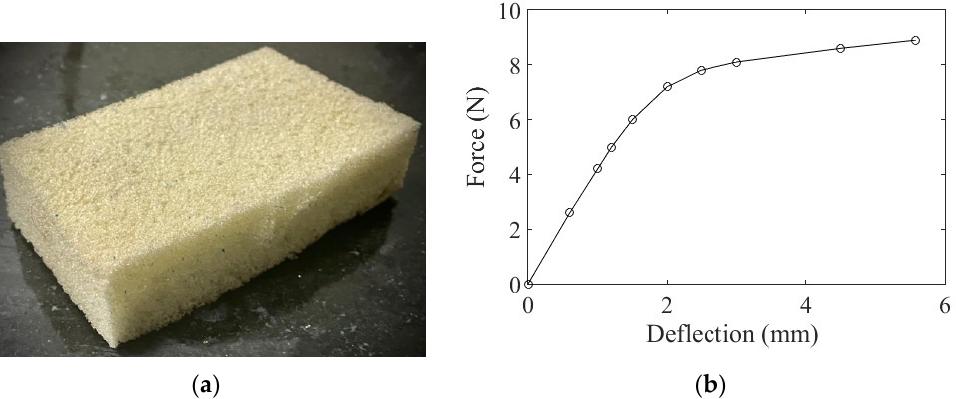
Figure 7. ( a ) Polyurethane foam used in the prototype (cross section of the foam is 20 × 30 mm). ( b ) Force ‐ deflection characteristics of the foam.